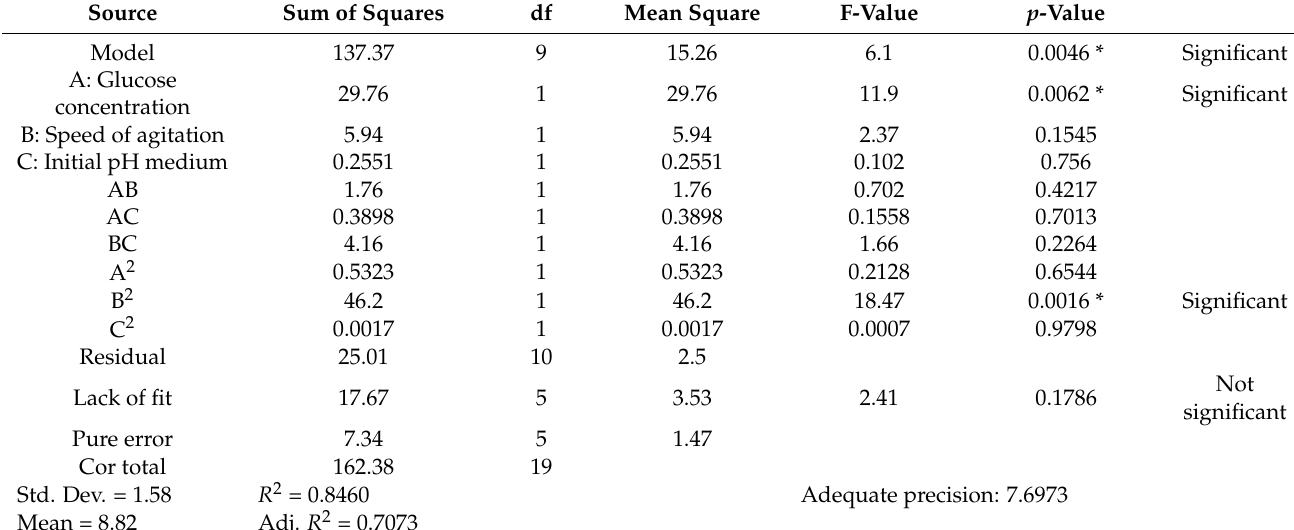
Table 3. The results of analysis of variance (ANOVA) generated from the CCD quadratic model for MB.